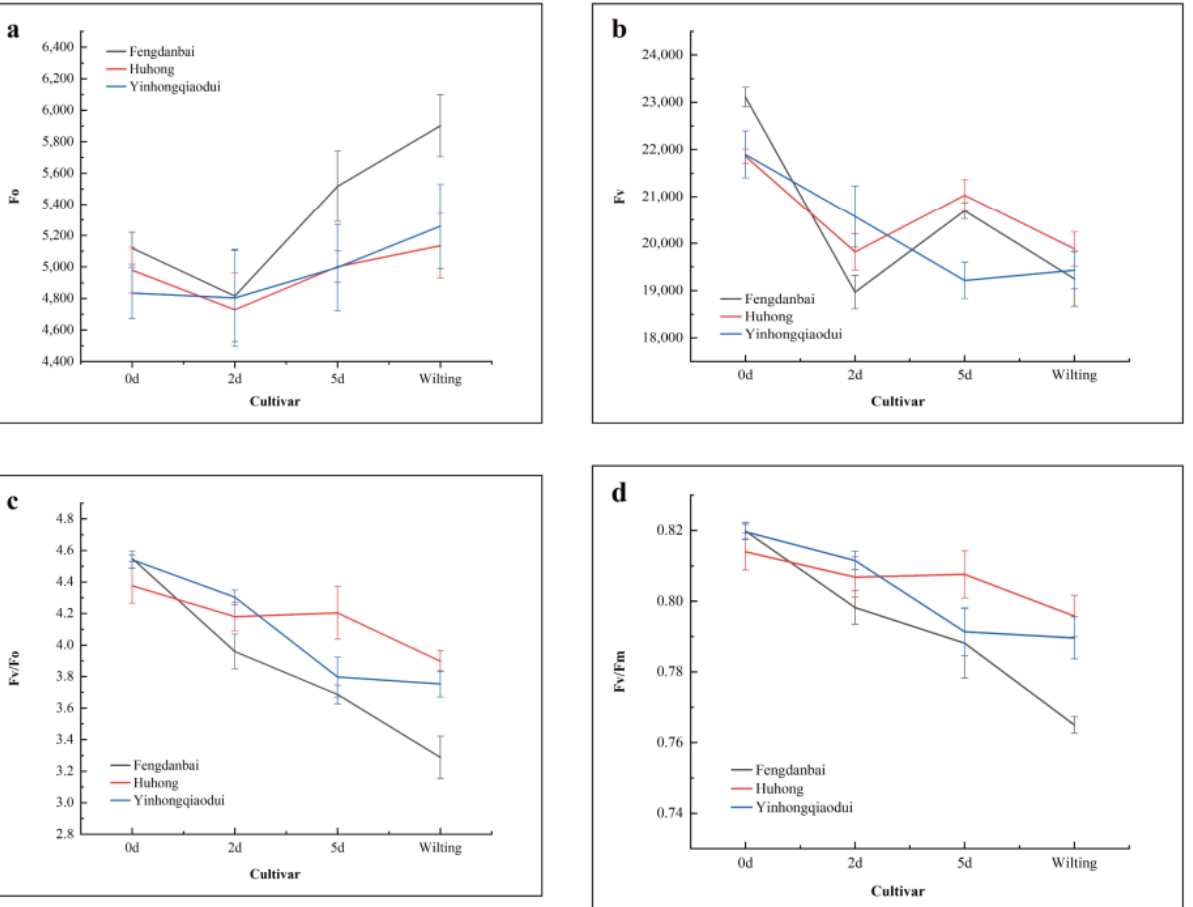
Figure 4. Effect of high-temperature stress on the basic parameters of chlorophyll fluorescence of ‘Fengdanbai’ ‘Yinhongqiaodui’ and ‘Huhong’ cultivars of peony leaves. Minimal fluorescence (all PS Ⅱ RCs are assumed to be open) (Fo; ( a )); maximal variable fluorescence (Fv; ( b )); ( c ): the potential activity of PS Ⅱ (Fv/Fo; ( c )); PS Ⅱ primary light energy conversion efficiency (Fv/Fm; ( d )).